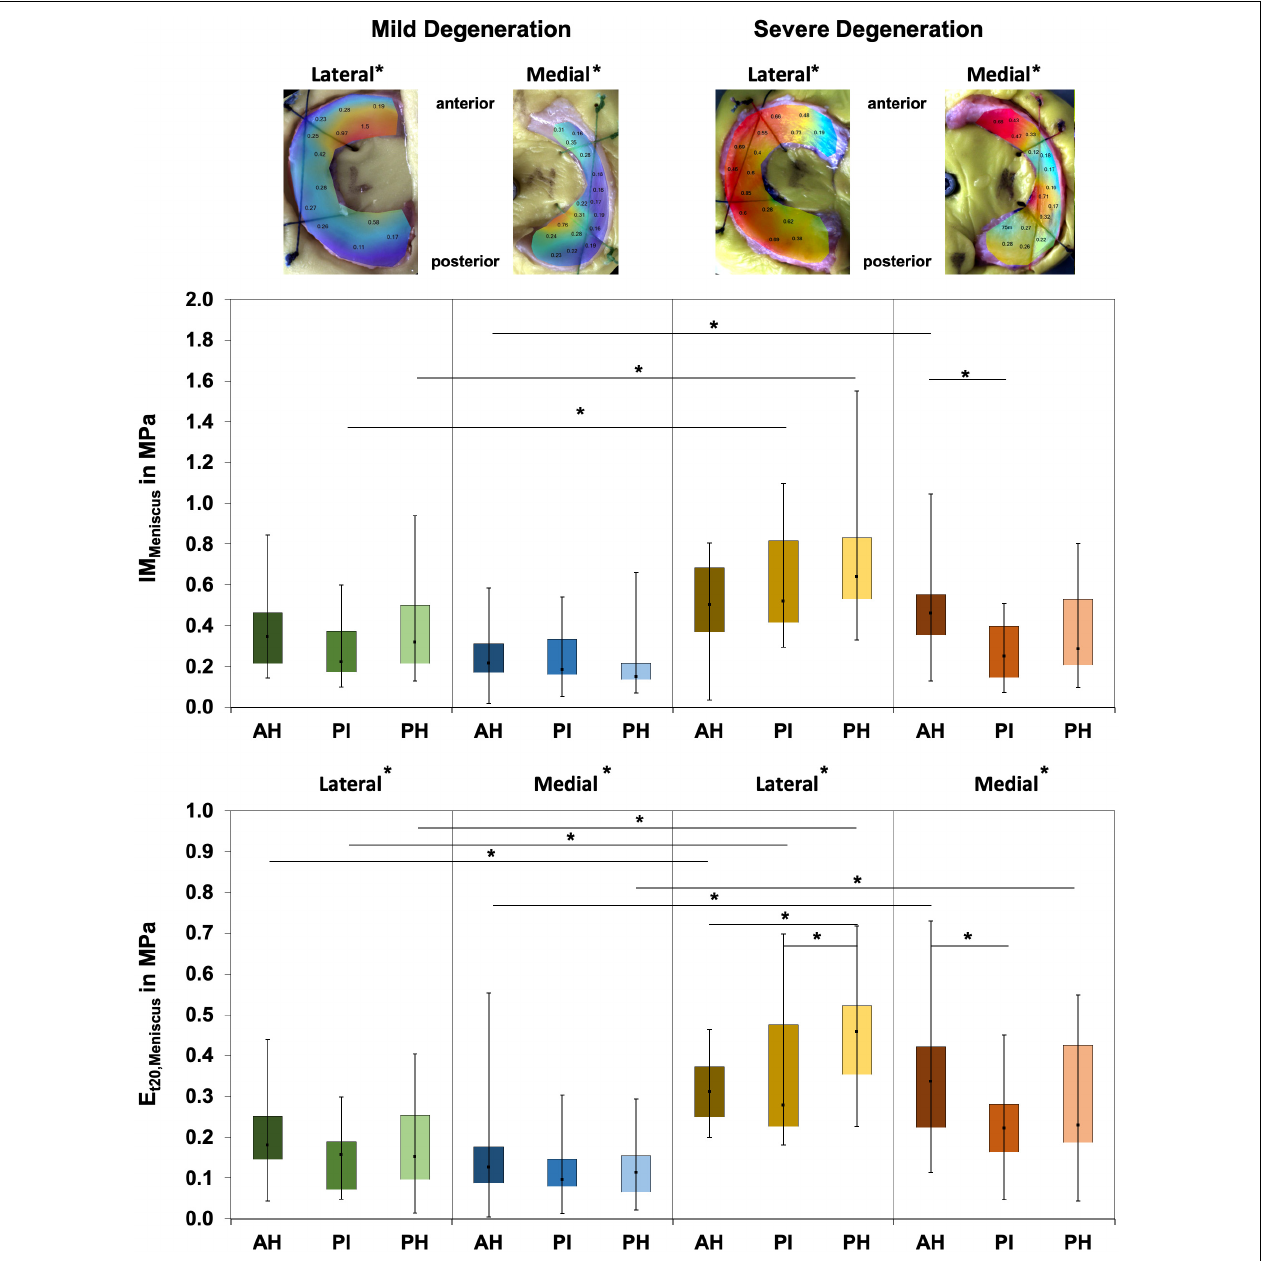
FIGURE 2 | Representative biomechanical mappings of the instantaneous modulus (IM) measurements of mildly and severely degenerated menisci, with all values given in megapascal. Middle row : Box plots (minimum, maximum, median, and 25th and 75th percentiles) of the lateral and medial IM Meniscus values in megapascal. Lower row : Box plots (minimum, maximum, median, and 25th and 75th percentiles) of the lateral and medial E t20 values in megapascal. Subdivided anatomical regions are: AH, anterior horn; PI, pars intermedia; PH, posterior horn. Non-parametric statistical analyses: n = 12; * p < 0.05. For reasons of readability, we marked significant differences between the mild and severe degeneration of the medial and lateral sides above the representative biomechanical mappings